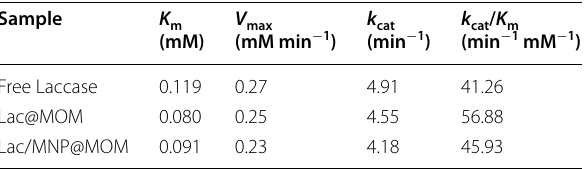
Table 1 Kinetic parameters of free laccase, Lac@MOM, and Lac/